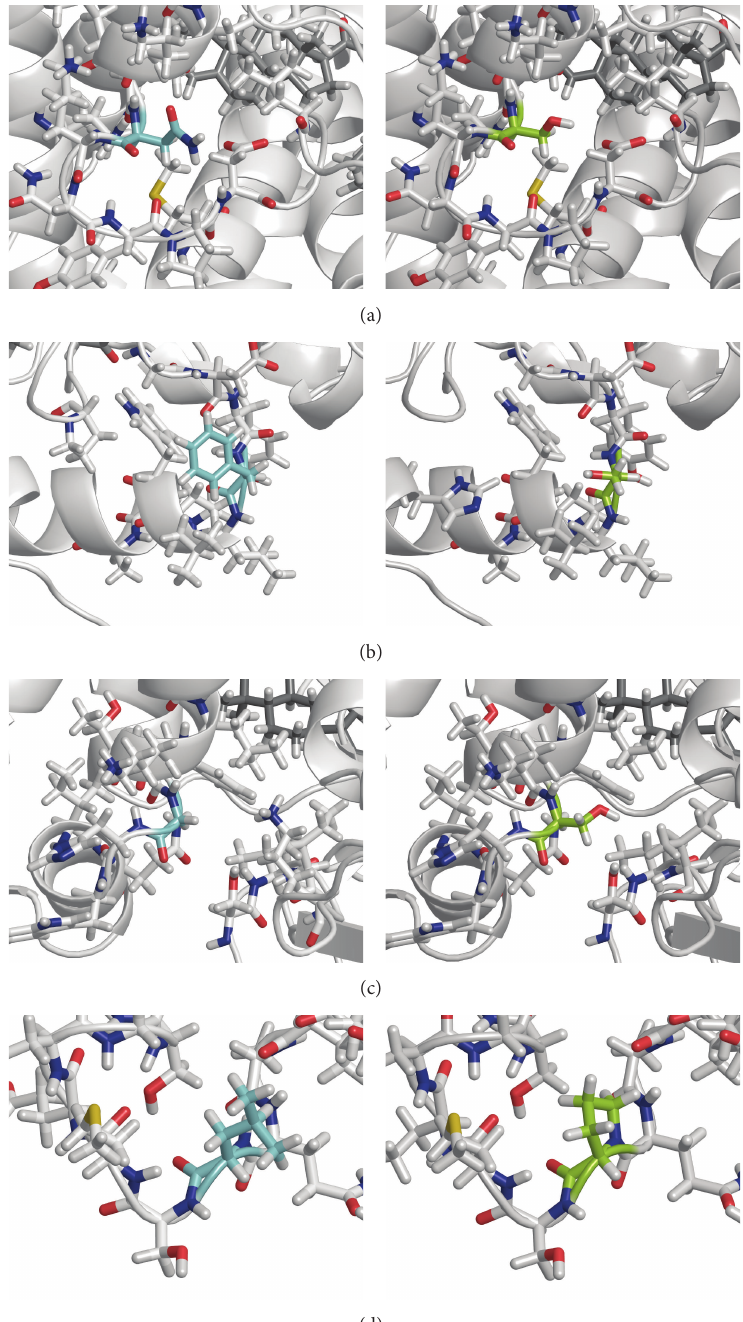
Figure2:Structuralchanges.Visualizationofthestructuralchangescausedbyfourmutations;left:wildtype;right:mutation;(a)p.Ser101Asn, (b) p.Ser113Phe, (c) p.Ser202Gly, and (d) p.Pro267Leu.